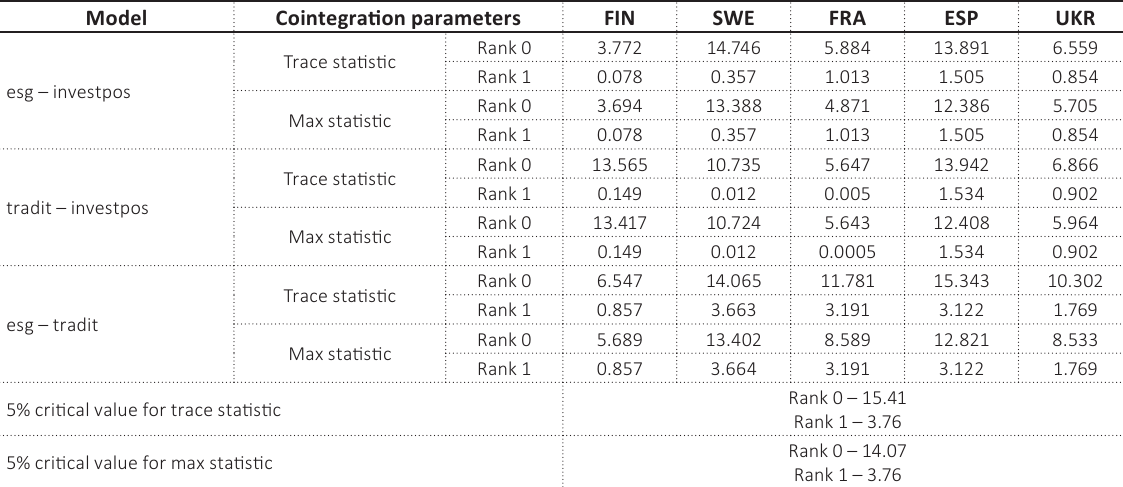
Table 12. Johansen cointegration test results Model